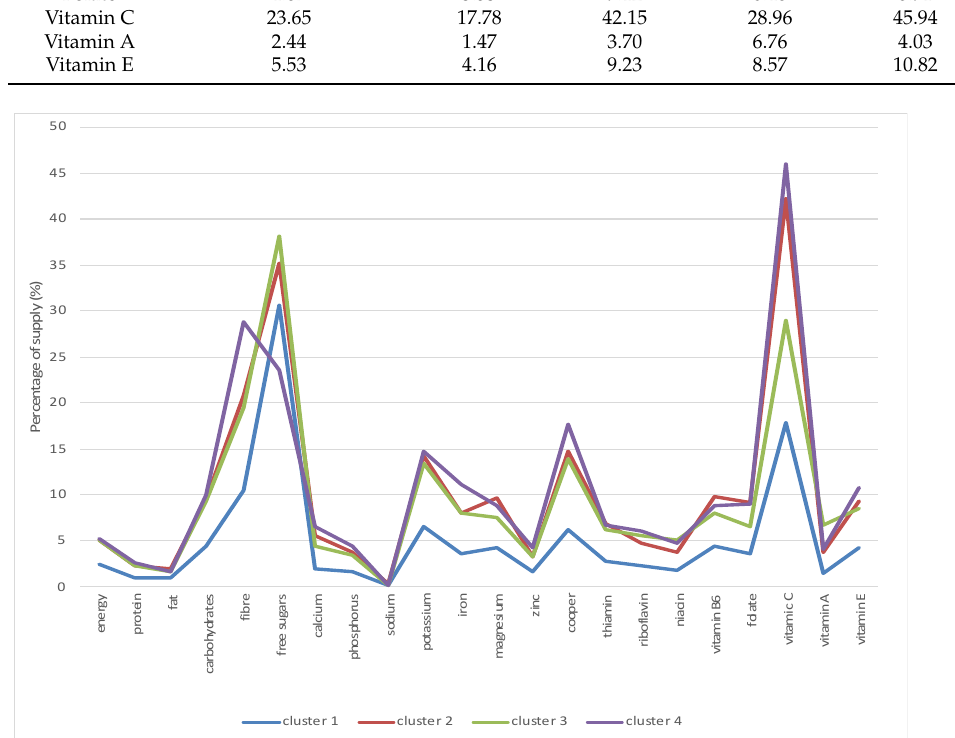
Figure 1. Cluster analysis: supply (in %) of energy and nutrients from fruit and fruit products.